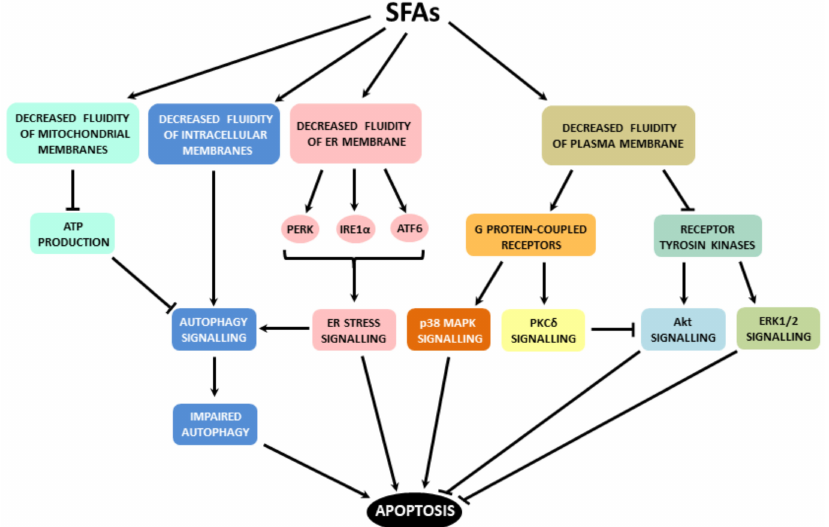
Figure 4. Suggested mechanisms of the possible involvement of decreased membrane fluidity in apoptosis induced by saturated fatty acids (SFAs) in pancreatic β